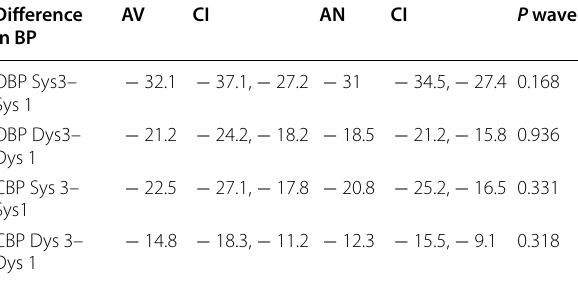
A/V, Amlodipine/Valsartan; A/N, Amlodipine/Nebivolol; OBP, office blood pressure; CBP, central BP; 1st, first visit without medications (A/V or A/N)